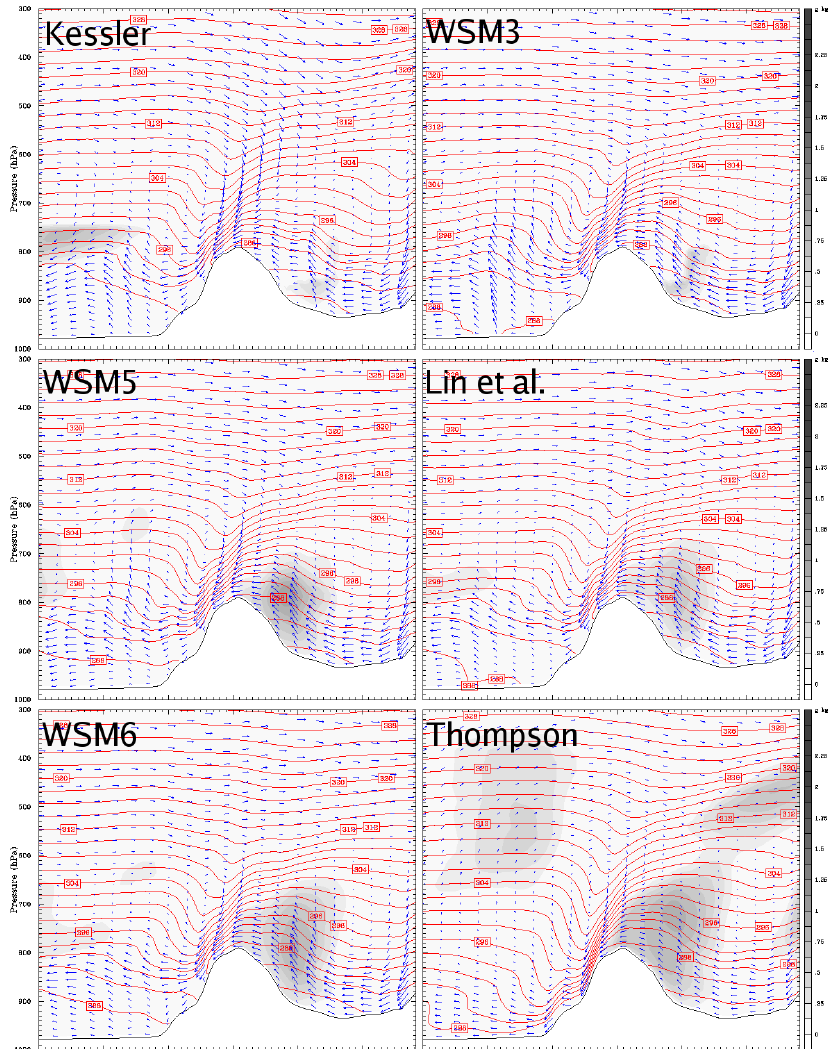
Figure 9: Cross section along line AB (cf. Fig. 4) showing potential temperature Fig. 9. Cross section along line AB (cf. Fig. 4) showing potential temperature (red lines) [K], wind along cross section (blue arrows) [ms − 1 ] (red lines) [K], wind along cross section (blue arrows) [ms − 1 ] and cloud water and cloud water mixing ratio [g/kg] at 06:00UTC 16 September 2004. micro-physics schemes are, from top left to bottom right: Kessler, mixing ratio [g/kg] at 0600 UTC 16 September 2004. micro-physics schemes are, WSM3, WSM5, Lin et al., WSM6 and from top left to bottom right: Kessler, WSM3, WSM5, Lin et al., WSM6 and Thompson.